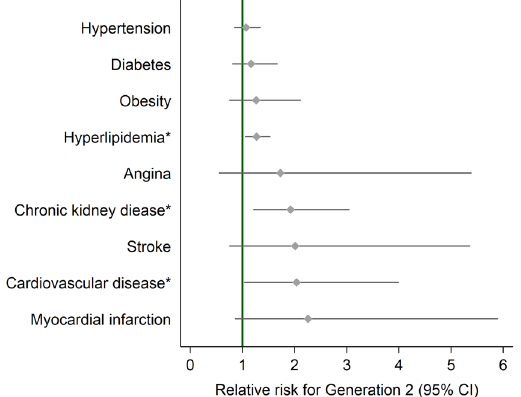
Figure 2. Relative risk of incident CVD and related conditions in second versus first-generation Indian individuals in Singapore. Asterisk indicates statistical significance (p < 0.05). Error bars represent 95% confidence intervals. Relative risk estimates have adjusted for age, gender, obesity, socioeconomic status, smoking, alcohol use, anti-diabetic, anti-hypertensive, and anti-cholesterol medications use, and mutually for the other CVD related conditions at